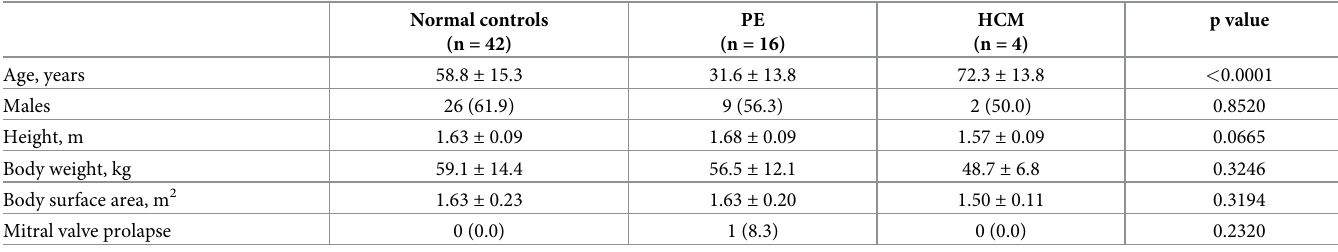
Table 1. Patient characteristics of normal controls and patients with PE older than 16